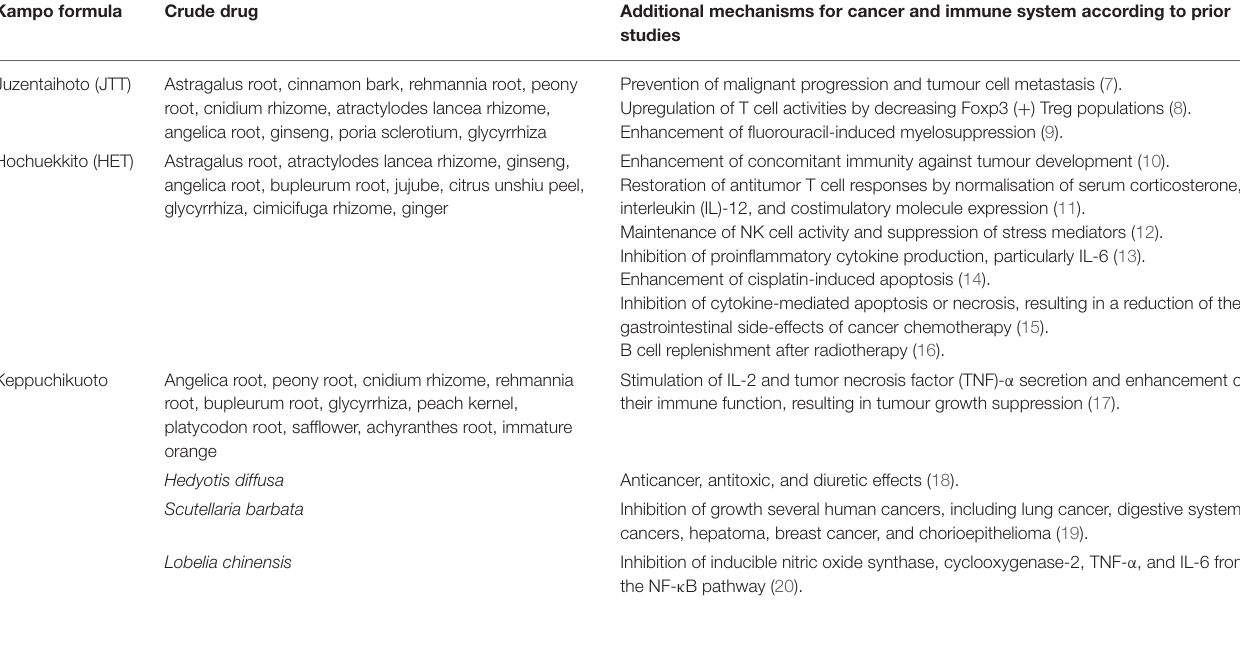
TABLE 1 | Kampo formula, its constituents, and mechanisms according to prior